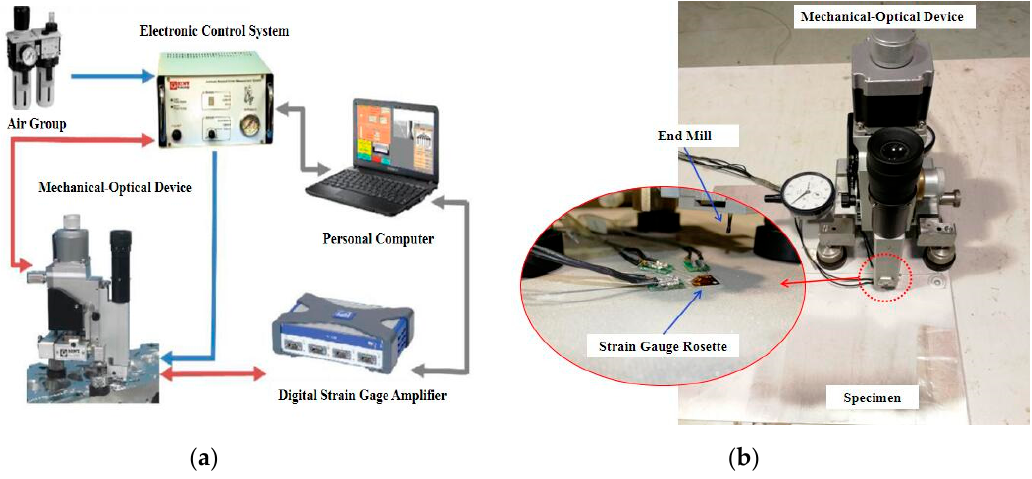
Figure 3. The schematic diagram of measuring residual stress by incremental center hole drilling (ICHD): ( a ) automatic hole drilling system and ( b ) measurement of residual stress.